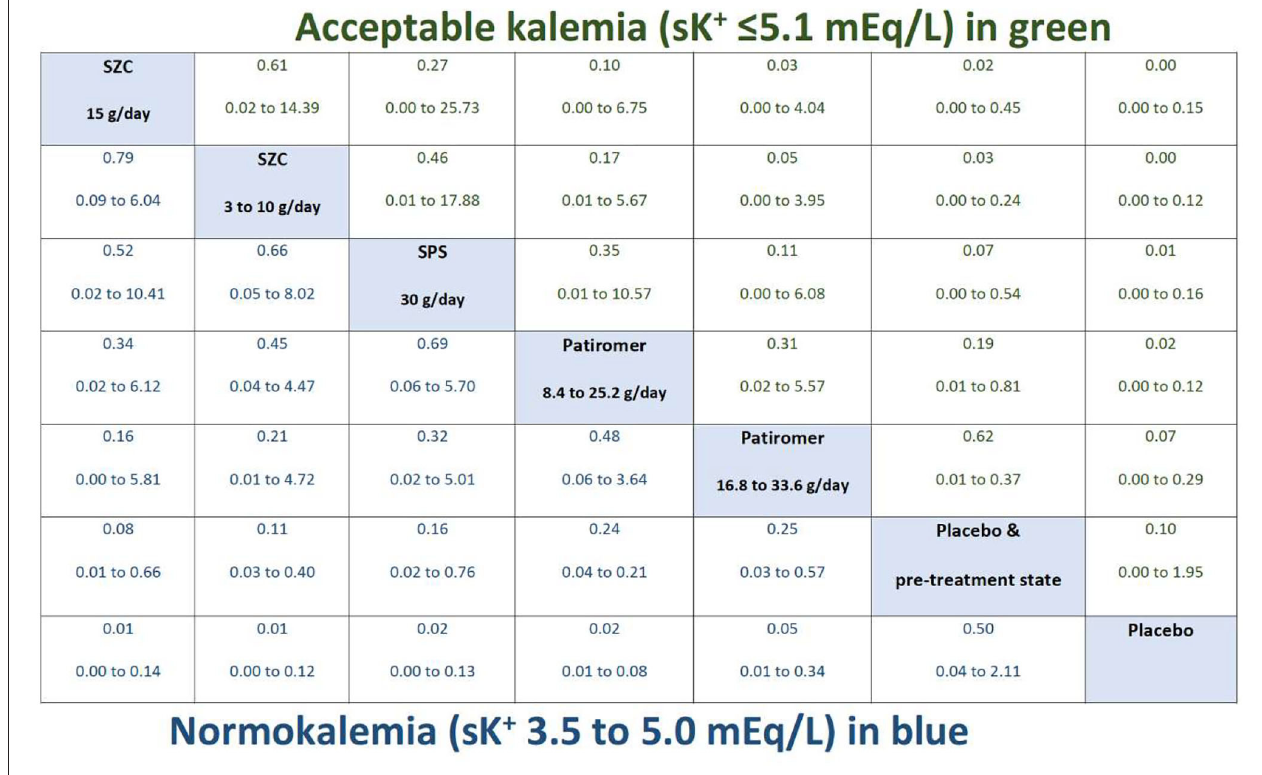
TABLE 1 | SUCRA-based ranking of the evaluated commercial potassium-binding